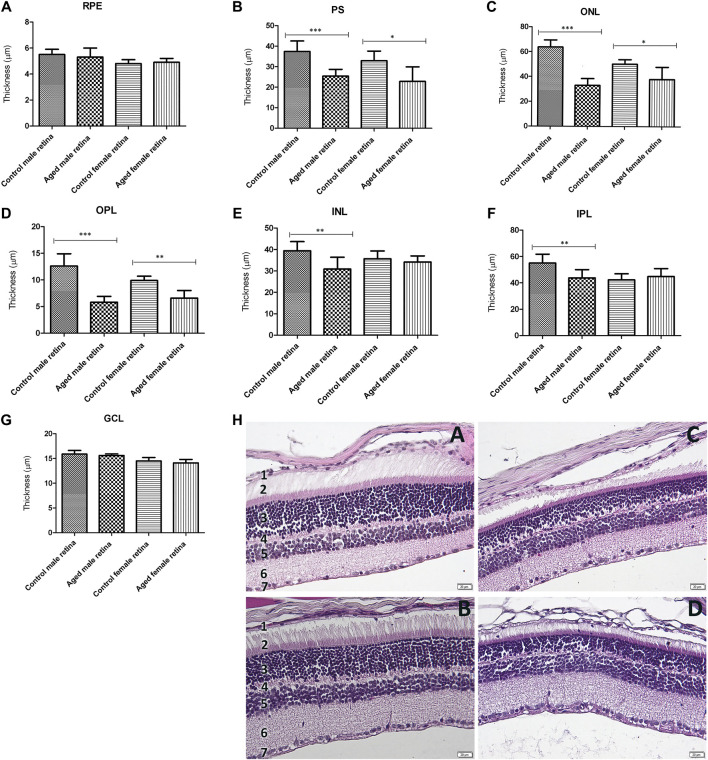
Retinal layer thickness of the aged retinas by gender. (A). The retinal pigment epithelium (RPE) thickness was not significantly modified between aged retinas and controls; (B). photoreceptor outer and inner segment layers (PS) were significantly thinner in both aged males (***p < 0.001 vs. controls) and females (*p < 0.05 vs. controls) compared to their controls, as well as the outer nuclear layer (ONL) (C) (aged males ***p < 0.001 vs. controls; aged females *p < 0.05 vs. controls), and the outer plexiform layer (OPL) (D) (aged males ***p < 0.001 vs. controls; aged females **p < 0.01 vs. controls). The inner nuclear layer (INL) (E) and inner plexiform layer (IPL) (F) were both significantly thinner in aged males than the controls (both **p < 0.01 vs. controls), while they did not show any significant differences between aged and control female retina; the retinal ganglion cell layer (RGL) thickness (G) was not modified between aged retinas and controls; (h.) histological aspect of the retinal layers of the control male (A), control female (B), aged male (C), and aged female (D) showing the reduction in thickness with age for both gender; the legend of the retinal layers: 1. RPE, 2. PS, 3. ONL, 4. OPL, 5. INL, 6. IPL, 7. RGL; thickness (µm) of retinal layers was reported as mean ± SD of n = 10 histological observations for each individual/group. Statistical significance was assessed by using the one-way ANOVA, followed by Tukey’s multiple comparisons test.